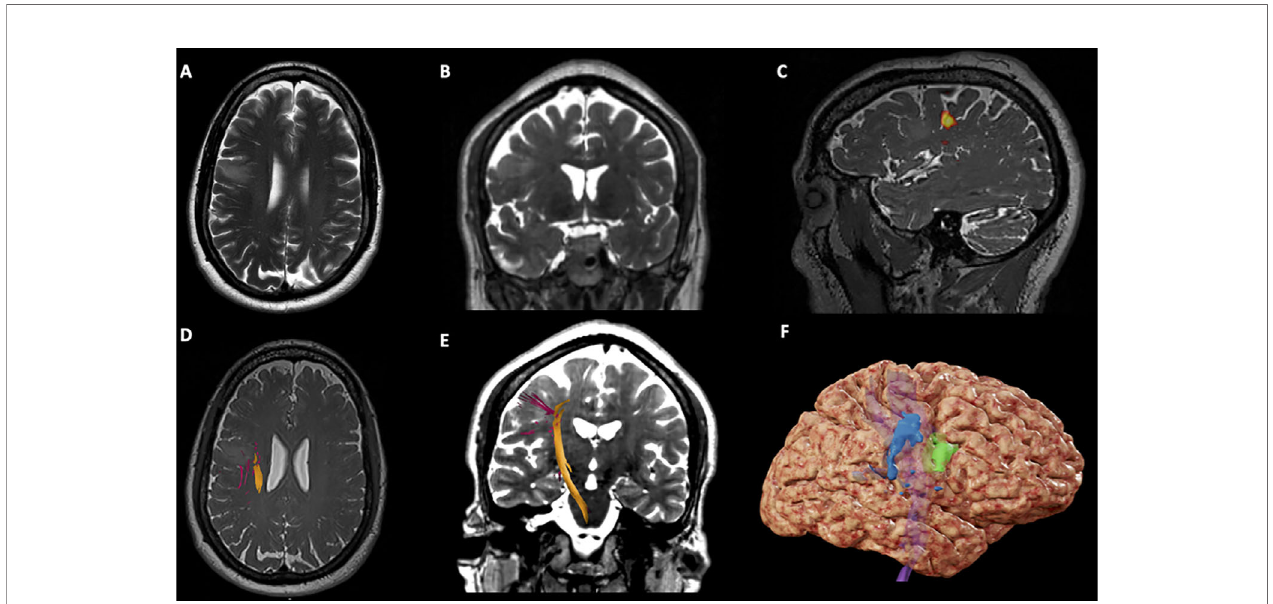
FIGURE 1 | Case 1 Surgical Plan. (A) Axial T2-weighted imaging showing an hypointensity in the right middle frontal gyrus, anterior to the precentral gyrus; (B) Coronal T2-weighted imaging showing an hypointensity in the right middle frontal gyrus; (C) Sagittal T2*-weighted imaging showing BOLD activation for lip purse test (yellow) on the lateral aspect of the right precentral gyrus; (D) Axial T2*-weighted imaging showing the right Corticospinal Tract (CST) on the deep and posterior margins of the tumor; (E) Coronal T2-weighted imaging showing the right CST descending from the precentral gyrus in the posterior aspect of the tumor; (F) 3D brain reconstruction showing the BOLD activation for lip purse segmented (in blue), the segmented tumor (green) and the CST deep (in